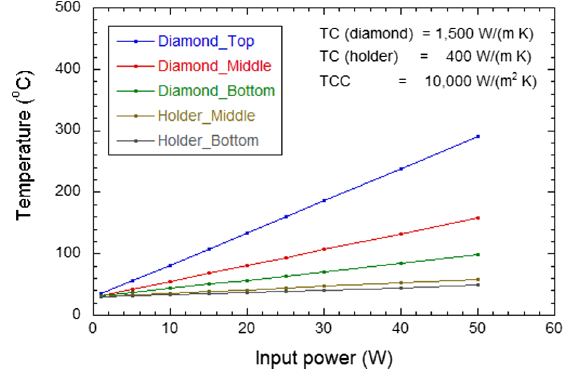
FIG. 12. Temperature variations of the quarter model due to difference in input power. TCC between diamond and copper is assumed to be 10 ; 000 W = ð m 2 K Þ .